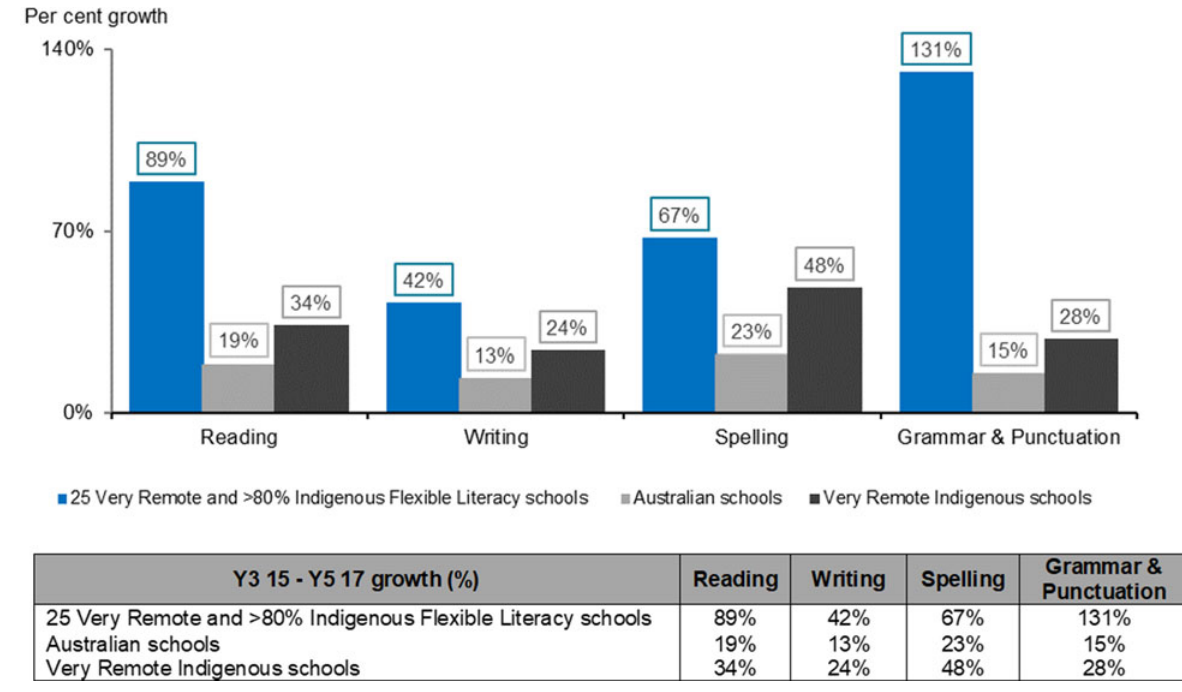
Fig. 1. NAPLAN literacy growth made by 25 schools in the Guenther and Osborne cohort compared to Australian and Very Remote Indigenous (Year 3 2015 – Year 5